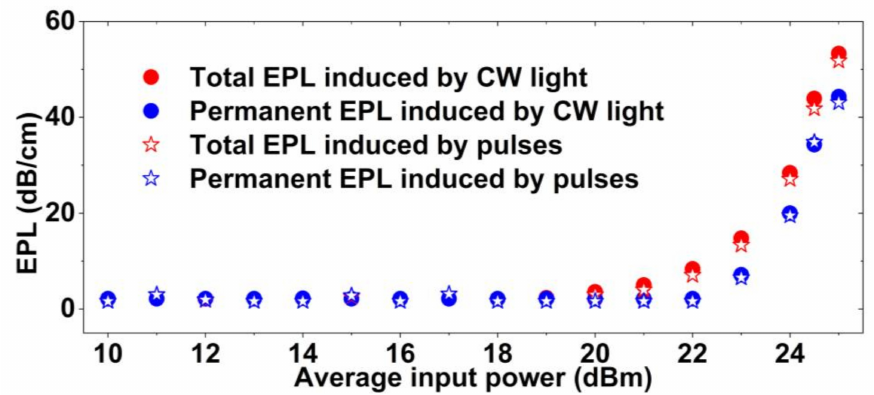
Figure 6. Experimental results of the total and permanent EPL induced by a CW light and optical pulses versus average input power for the hybrid waveguides coated with 1 layer of